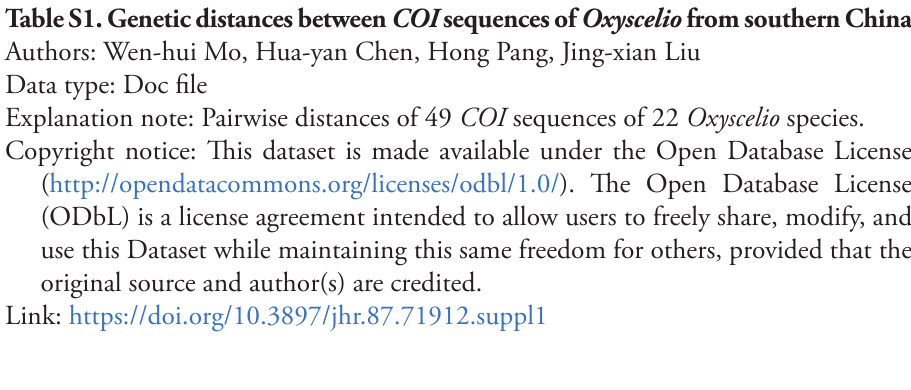
Table S1. Genetic distances between COI sequences of Oxyscelio from southern China Authors: Wen-hui Mo, Hua-yan Chen, Hong Pang, Jing-xian Liu Data type: Doc